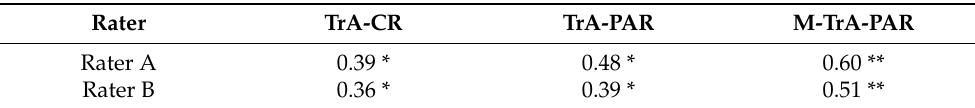
Table 4. Correlations between manual palpation and muscle thickness assessing Transversus Abdo- minis (TrA) Muscle